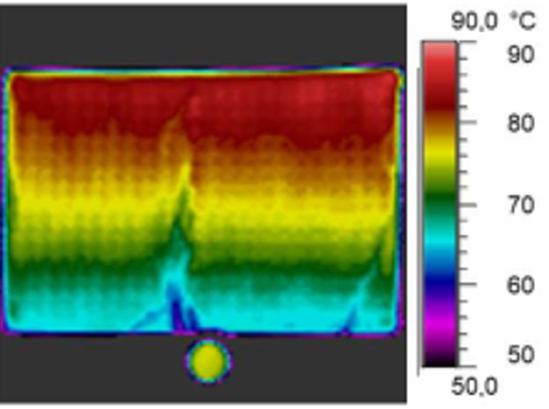
Figure 19. Delonghi -22 radiator—surface temperature distribution according thermography mea- surements, t s = 89.6 ◦ C, t r = 69.3 ◦ C, t i = 19.5 ◦ C, mass flow rate q m = 0.0247 kg/s—measurement 2.